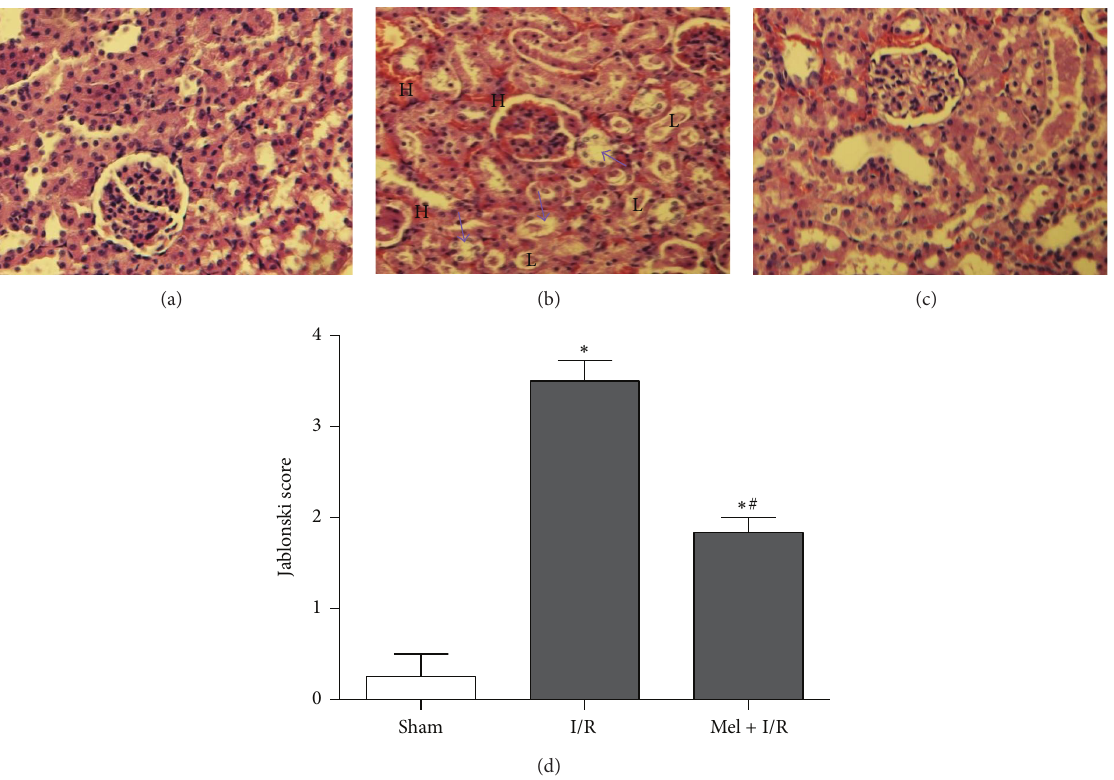
Figure 2: Representative histological photographs of kidney tissues from Sham (a), I/R (b), and Mel + I/R (c) groups (H&E) × 400. Semiquantitative assessment of renal necrosis among the different experimental groups using the Jablonski score (d). The arrows denote brush border loss, “H” denotes hemorrhage, and “L” denotes nuclei loss. Results are expressed as mean ± SEM ( 𝑛 = 6 for each group). ∗ 𝑝 < 0.05 versus Sham. # 𝑝 < 0.05 versus